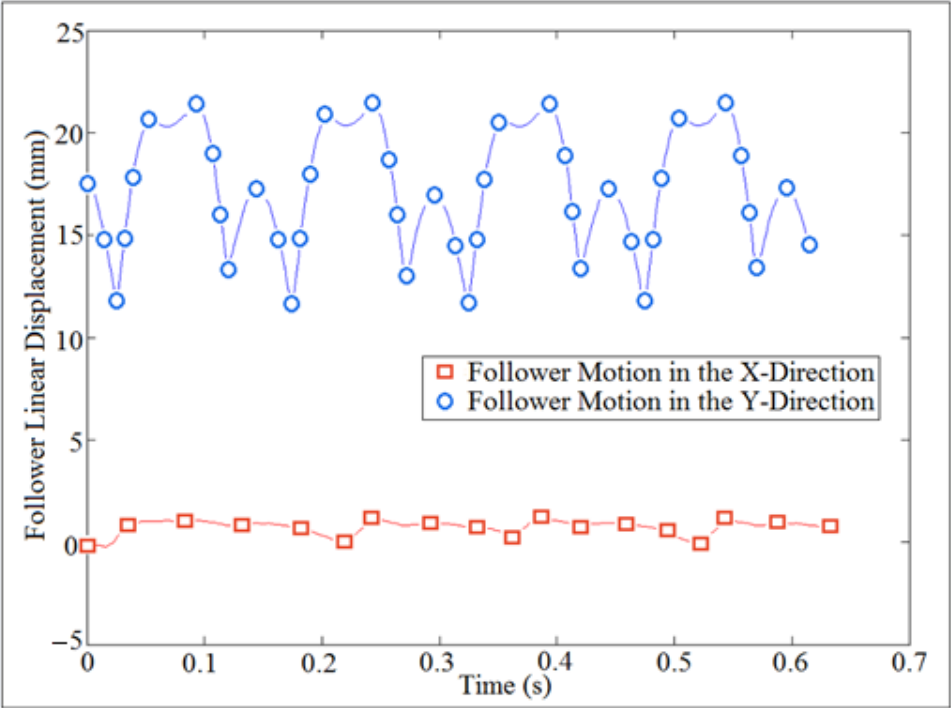
Figure 7. Nonlinear response of the follower displacement in the x and y directions. Four different internal distance of the follower guide such as (I.D. = 16, 17, 18, 19 mm) were used in the simulation of the follower displacement and the contact force in which